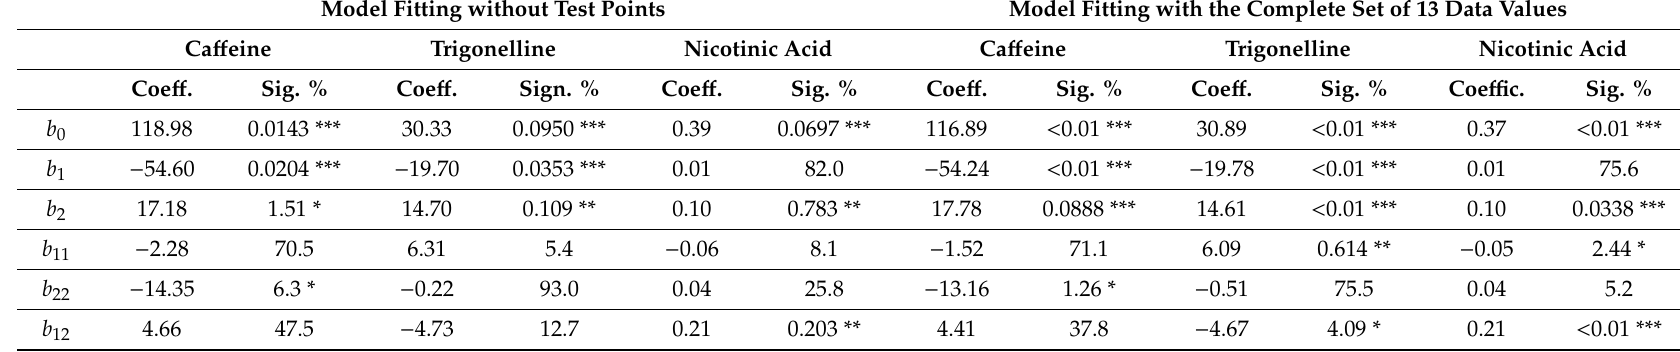
Table 5. Estimated coe ffi cients of the second-order polynomial model of Equation 1 for the three response variables, along with the significant values, where the symbol * stands for a p -value ( p ) ≤ 0.05, ** for p ≤ 0.01, and *** for p ≤